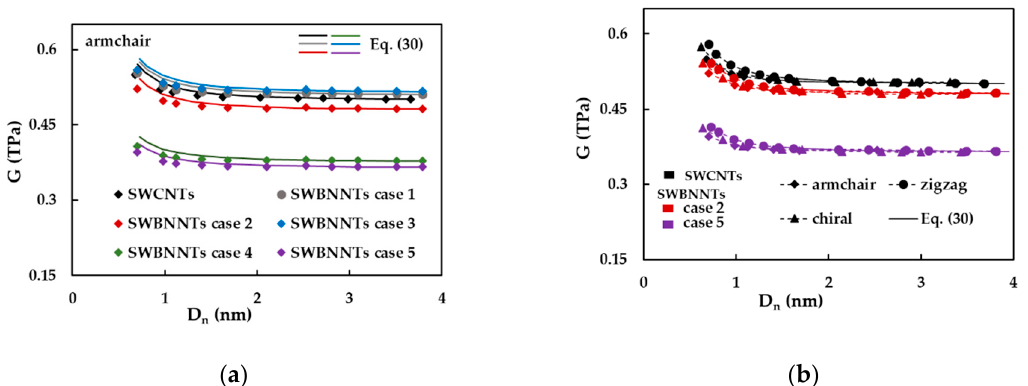
Figure 10. The evolutions of the shear modulus, G, as a function of the nanotube diameter, D n , for: ( a ) armchair SWBNNTs (cases 1–5) and SWCNTs, and ( b ) cases 2 and 5 of armchair, zigzag and chiral SWBNNTs and SWCNTs.